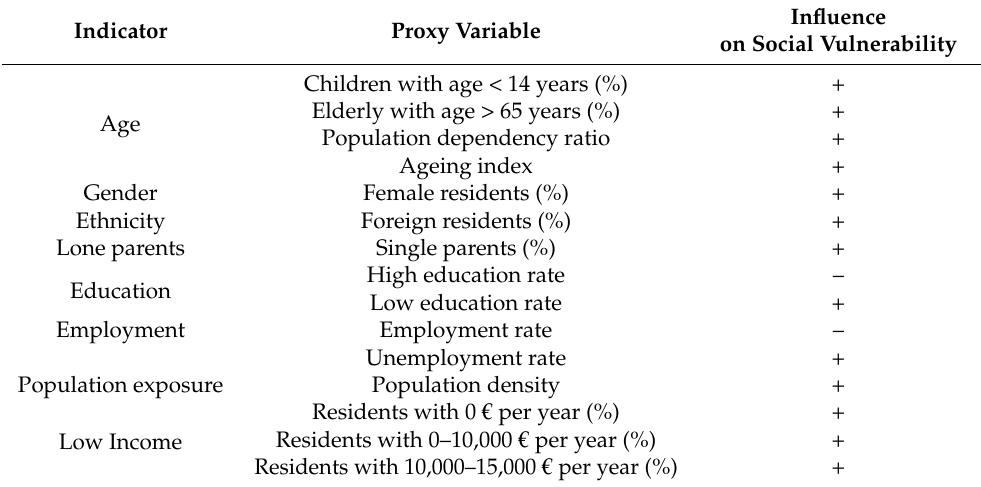
Table 2. Social vulnerability indicators with their proxy variables. The relative influence of each proxy variable on the social vulnerability is defined as (+) in the case of a positive correlation and as ( − ) in the case of no influence or negative influence. Influence Indicator Proxy Variable on Social Vulnerability Children with age < 14 years (%) + Elderly with age > 65 years (%) + Age Population dependency ratio + Ageing index + Gender Female residents (%) + Ethnicity Foreign residents (%) + Lone parents Single parents (%) + High education rate – Education Low education rate + Employment Employment rate – Unemployment rate + Population exposure Population density + Residents with 0 € per year (%) + Residents with 0–10,000 € per year (%) Low Income Residents with 10,000–15,000 € per year